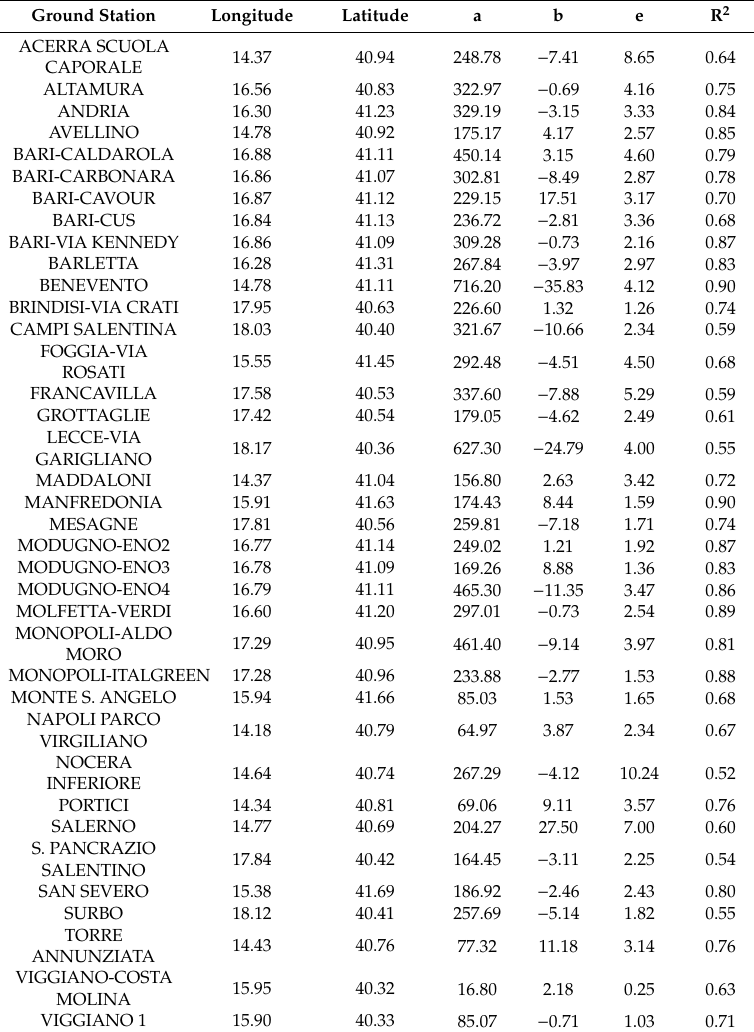
Table 2. As Table 1, but for the South Italy ground